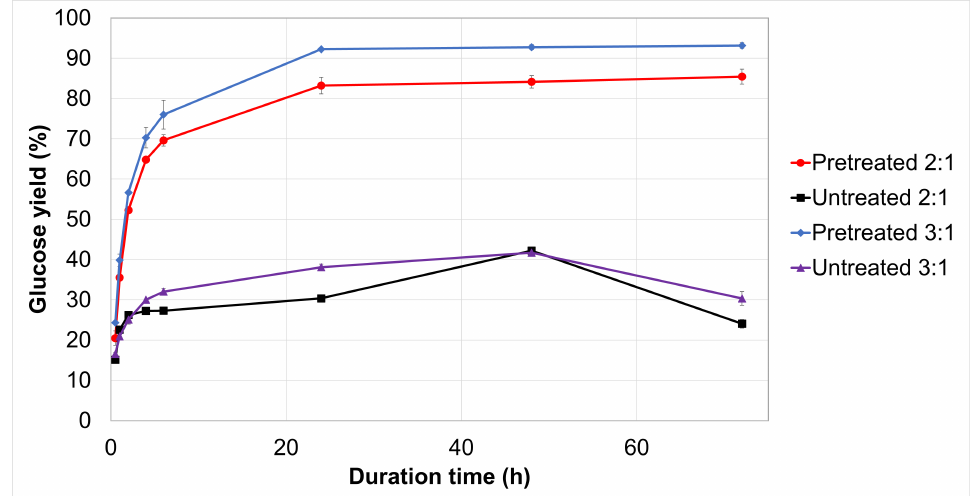
Figure 3. Glucose yield for untreated and pretreated corn stover. Experiments were performed for two different ratios of CTec2:HTec2 enzymes.